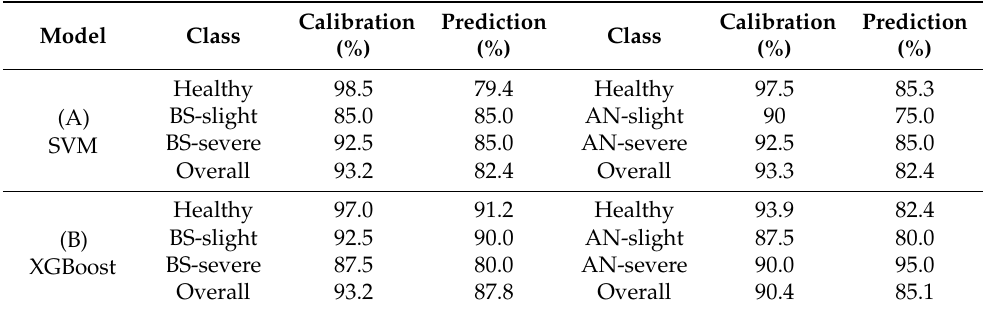
Table 5. Classification results of different degrees (slight and severe) of diseased cucumbers based on SVM and XGBoost algorithms *.